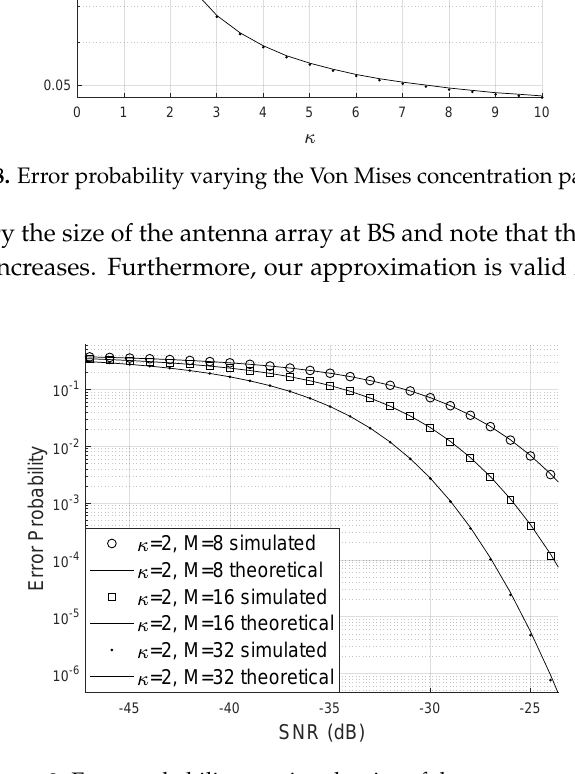
Figure 9. Error probability varying the size of the antenna array.